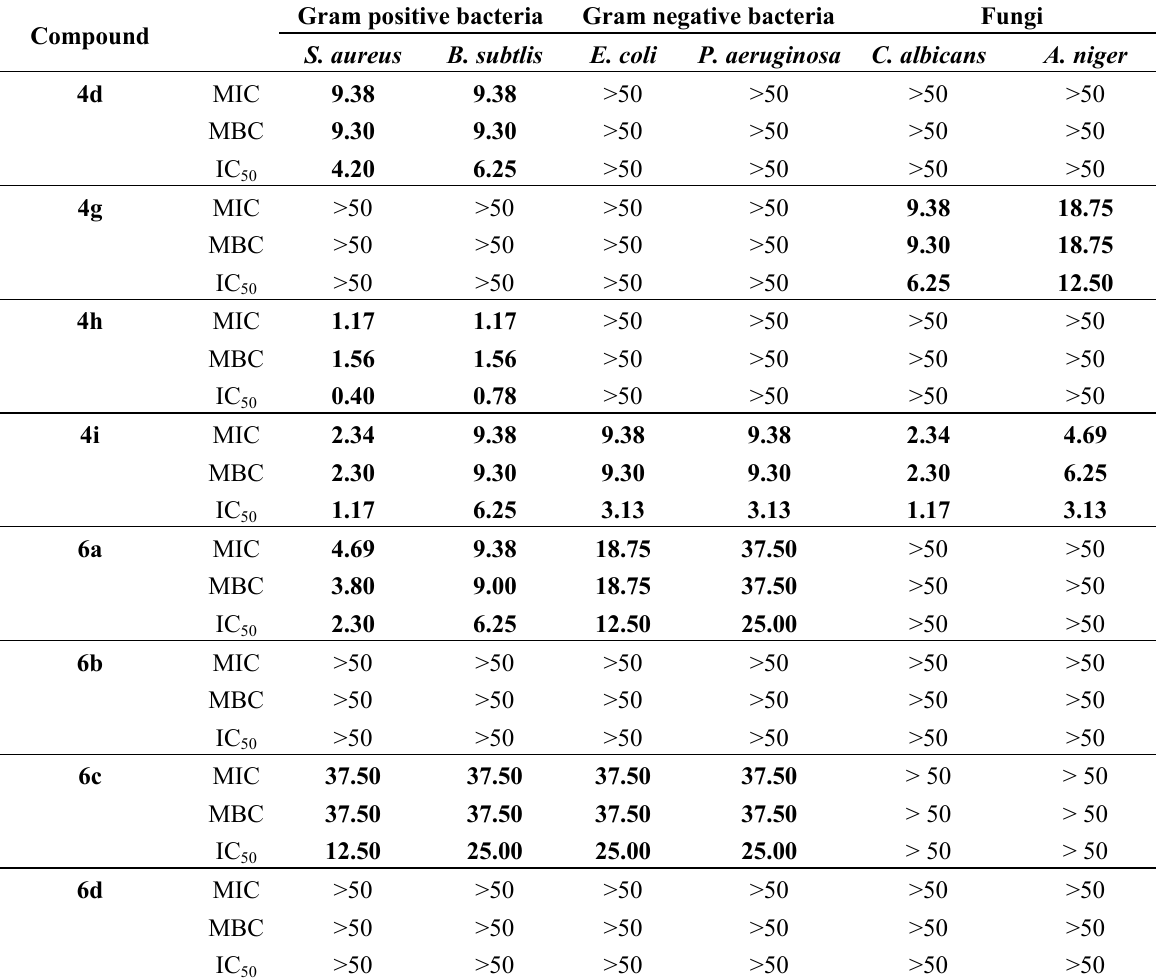
Table 1. Antimicrobial activity of the synthesized compounds expressed as minimum inhibitory concentration (MIC), minimum bactericidal concentration (MBC) and concentration that inhibit 50% of microorganisms (IC strains based on two fold serial dilution technique.